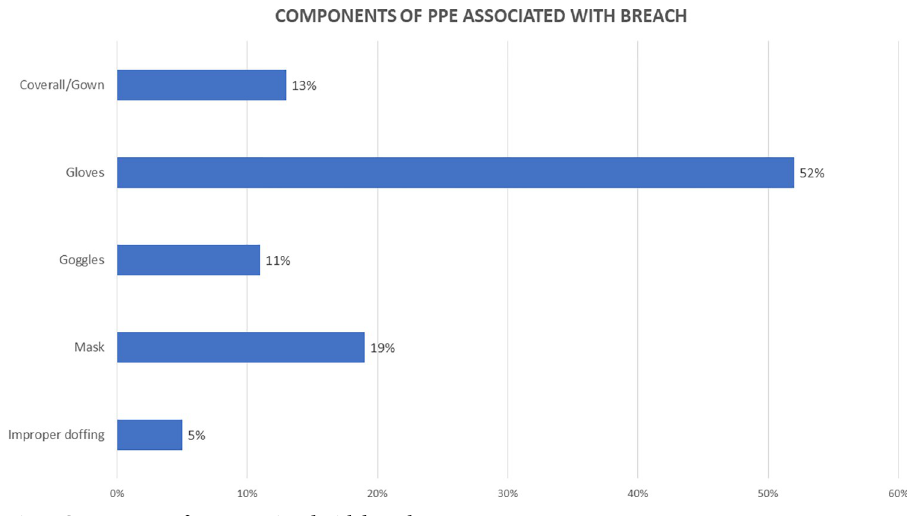
Fig 4. Components of PPE associated with breach.